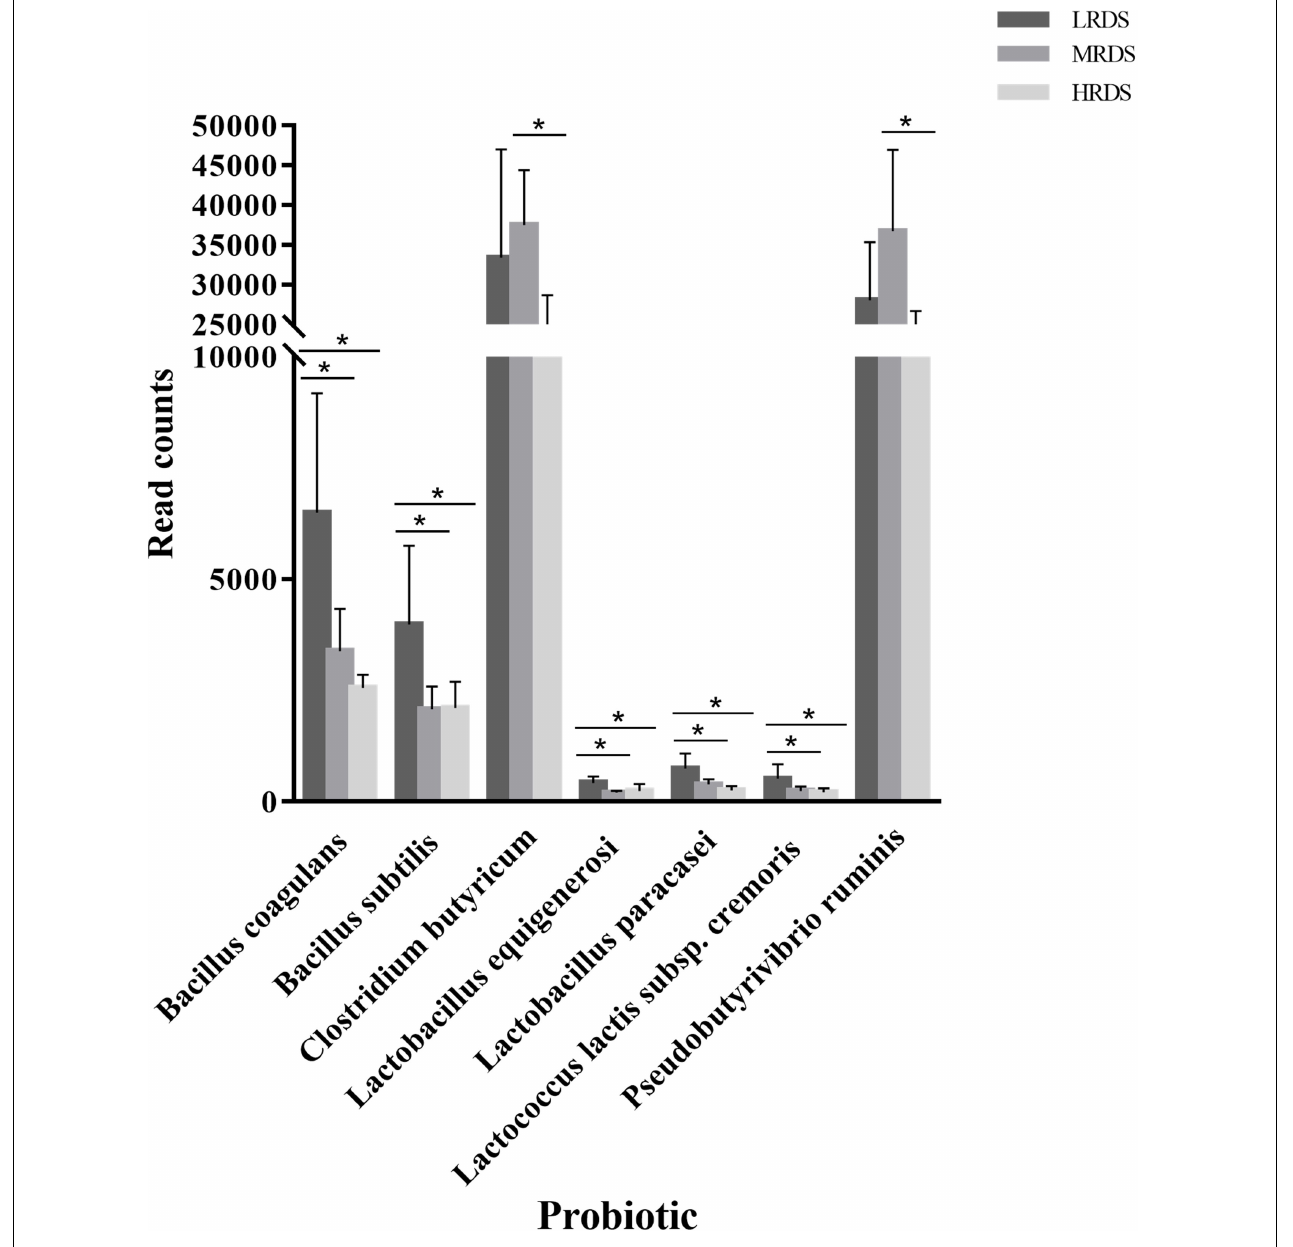
FIGURE 8 | Comparisons of the abundance of the Probio annotated probiotics.